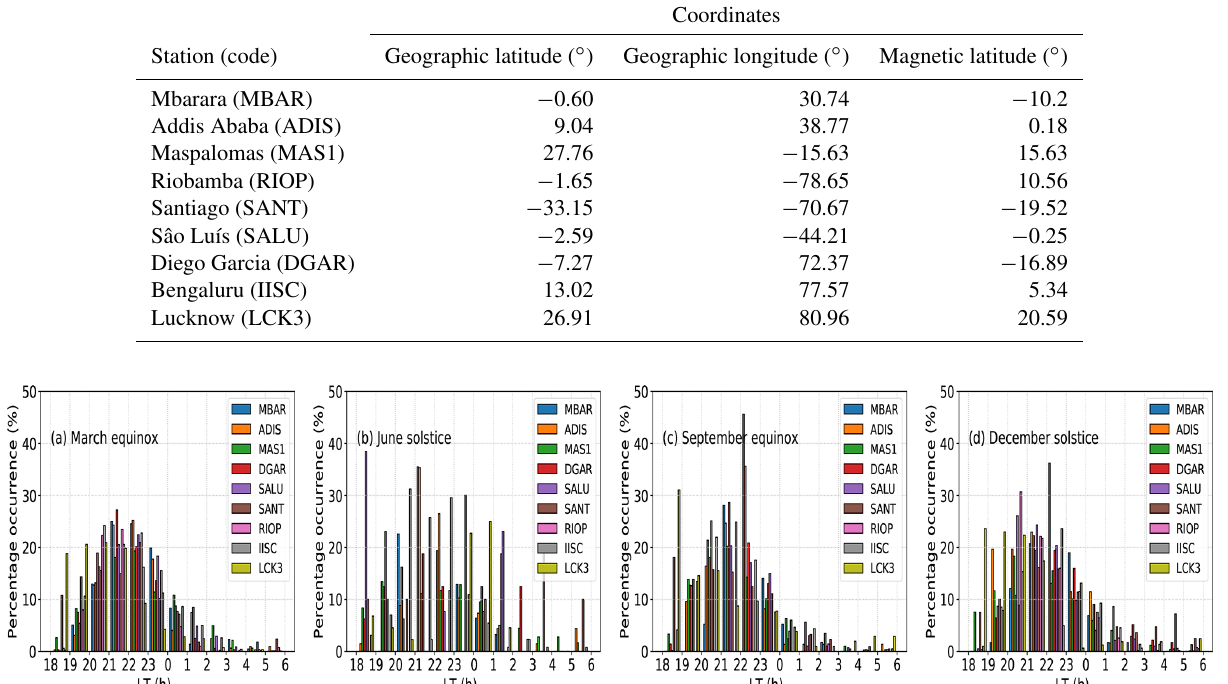
Table 2. Coordinates of IGS stations used in this study.